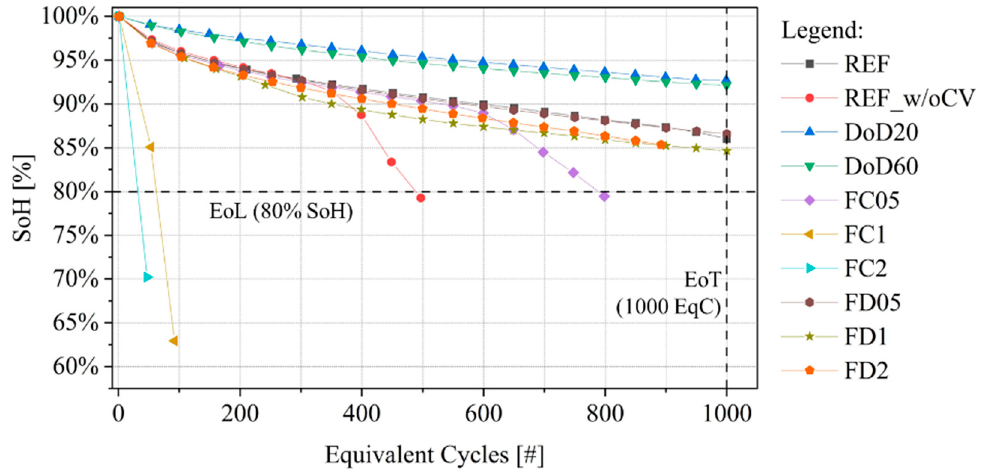
Figure 2. SoH evolution curves over EqC for the cells under investigation.